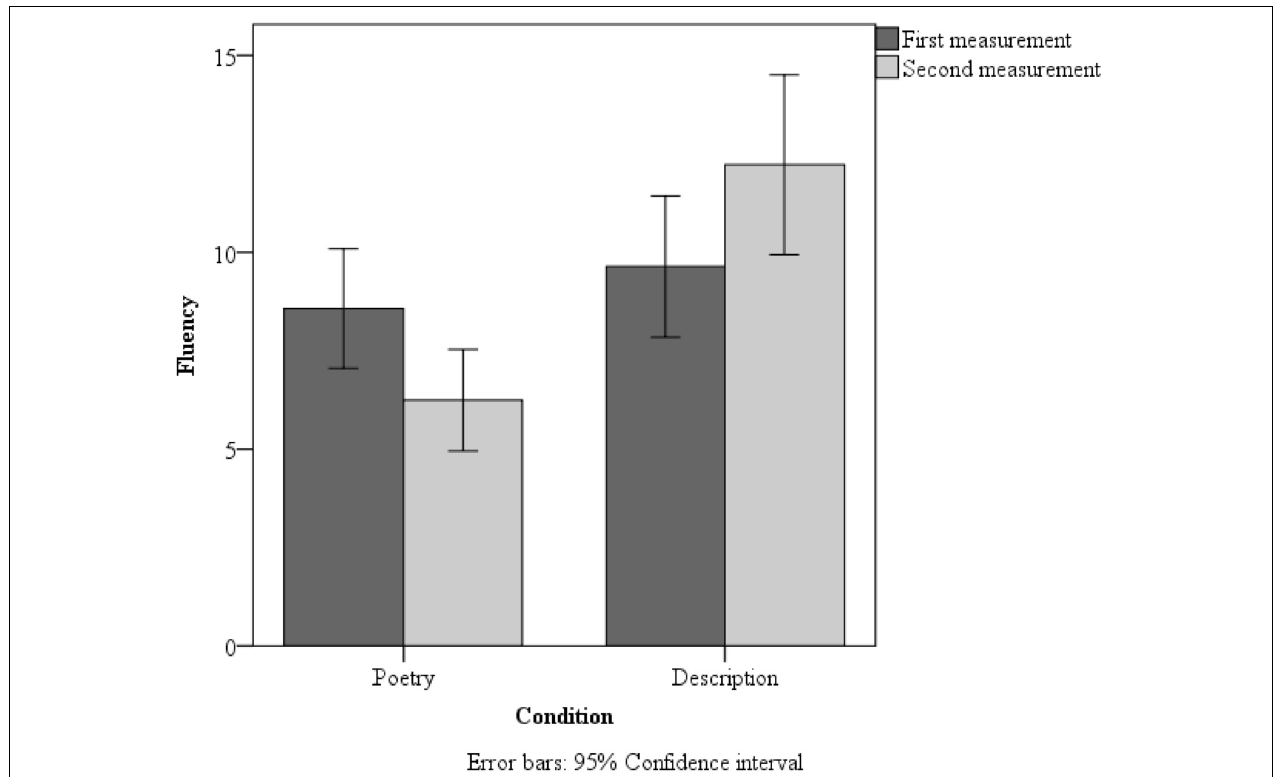
FIGURE 4 | Mean fluency scores in the poetry-reading group and description-reading group in the first and second measurement in Study 2. Error bars: 95% Confidence interval.